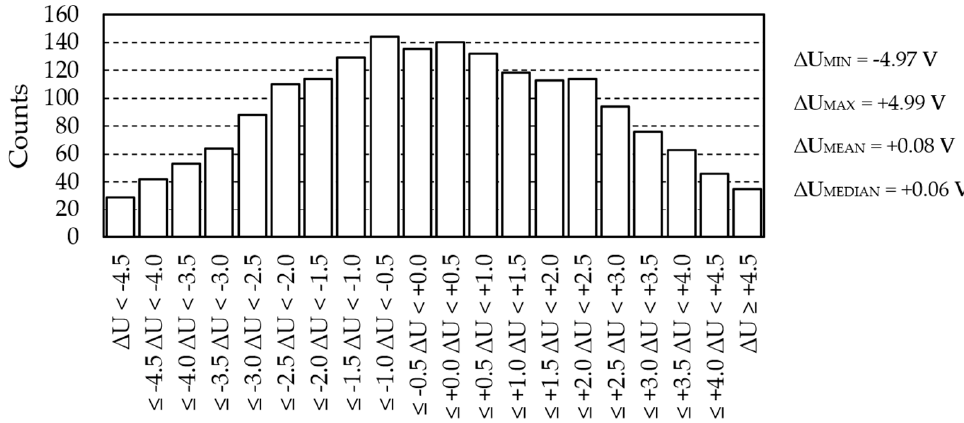
Figure 8. Voltage changes in the random group.